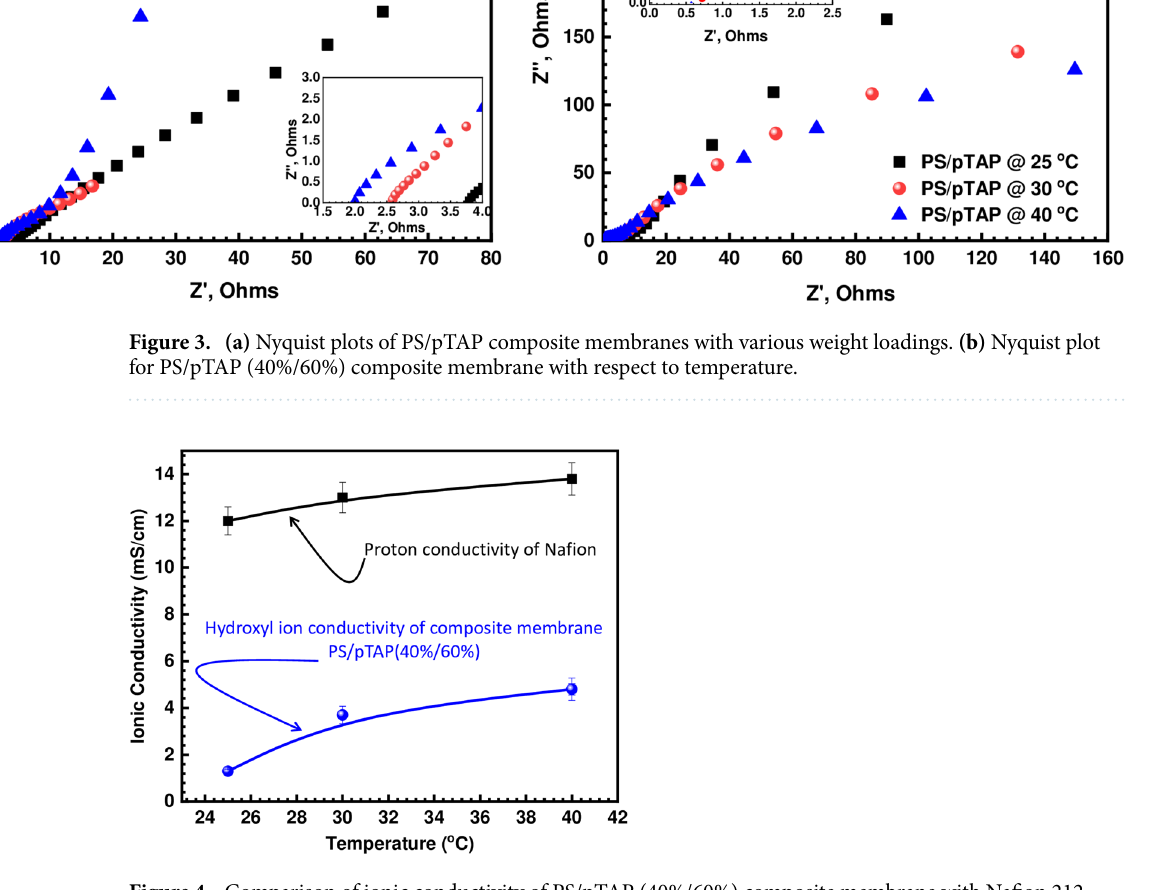
Figure 4. Comparison of ionic conductivity of PS/pTAP (40%/60%) composite membrane with Nafion